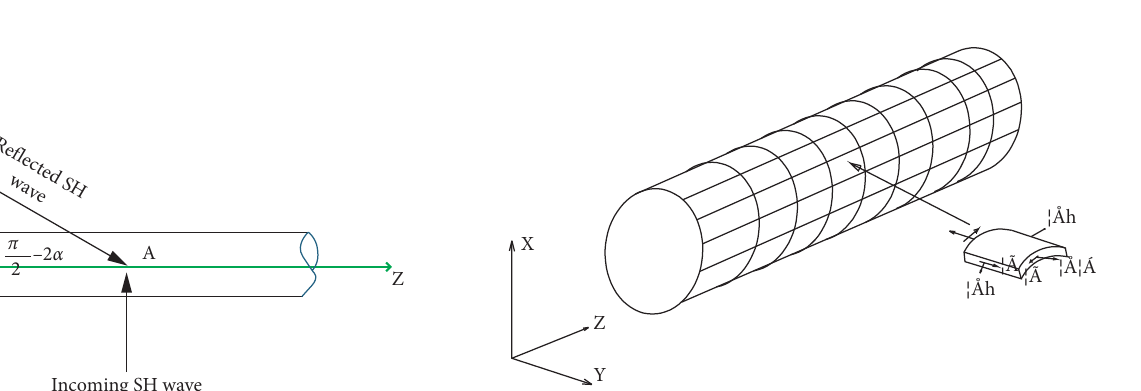
Figure 2: The illustration of the superposition of axial displace- ment at A point.